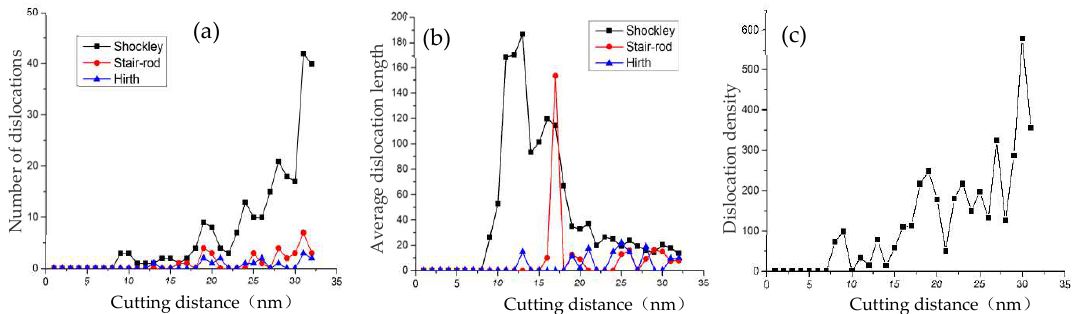
Figure 8. Number, length, and density change in dislocations during plowing. ( a ) Change in number of dislocations; ( b ) change in dislocation length; and ( c ) change in dislocation density.